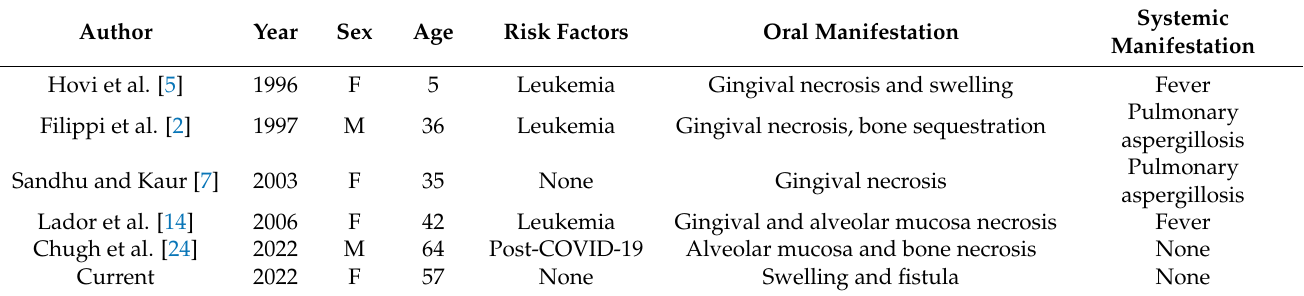
Table 1. Review of mandibular Aspergillus osteomyelitis reported in the English-language